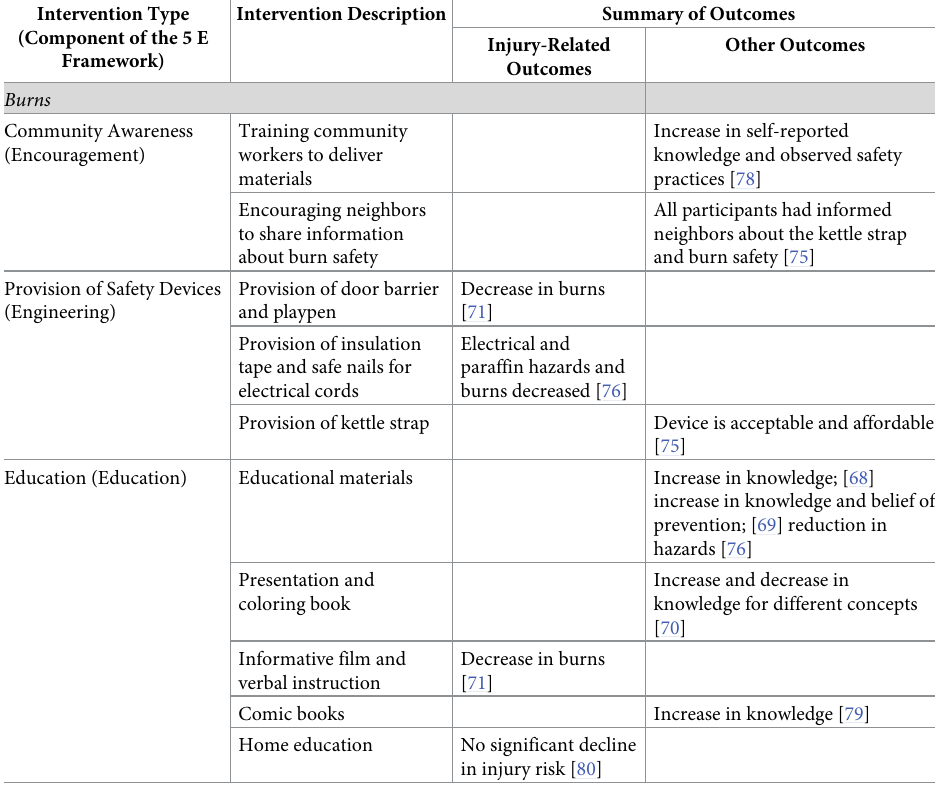
Table 4. Summary of intervention outcomes for injury types: